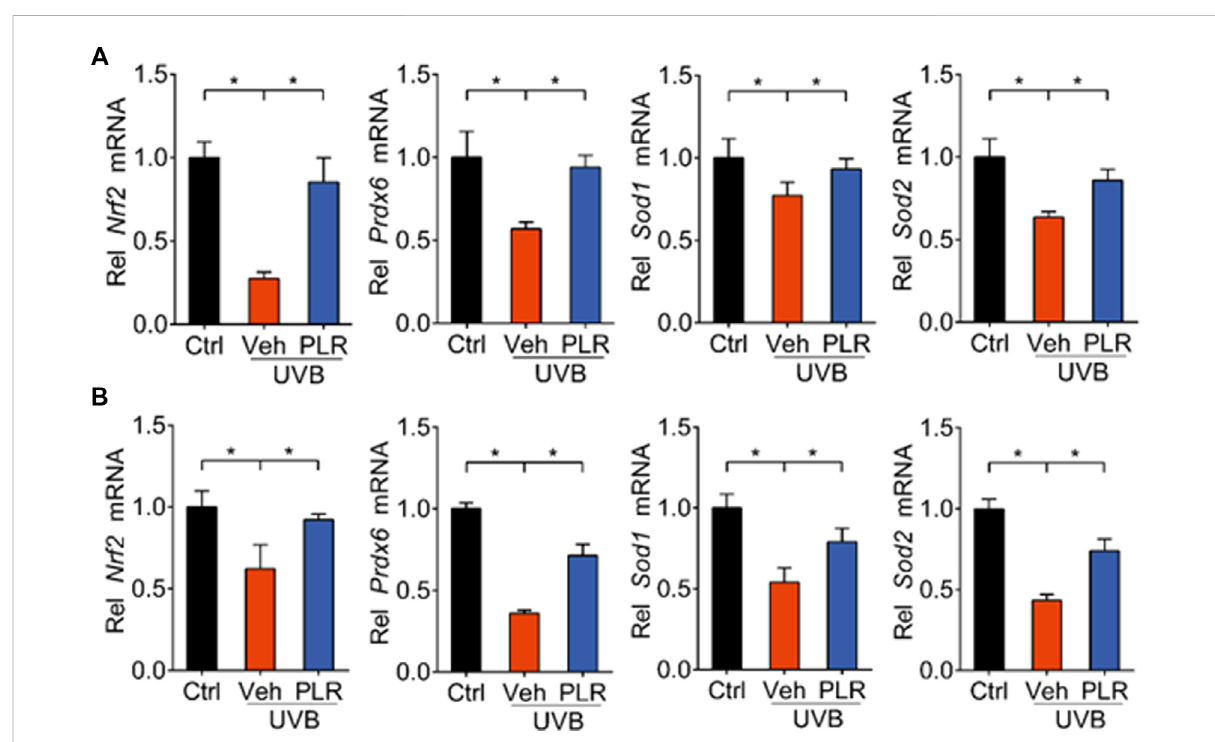
FIGURE 6 PLR increases expression of Nrf2 and antioxidant genes. (A) Expression levels of Nrf2 , Prdx6 , Sod1 , and Sod2 mRNAs in mouse skin. 400 mg/kg PLR was used to treat the skin of mice. (B) Expression levels of Nrf2 , Prdx6 , Sod1 , and Sod2 mRNAs in L929 cells. 1 μ g/ml PLR was used to treat the L929 cells. Data are presented as mean ± SD ( n = 3). * p < 0.05. Veh,